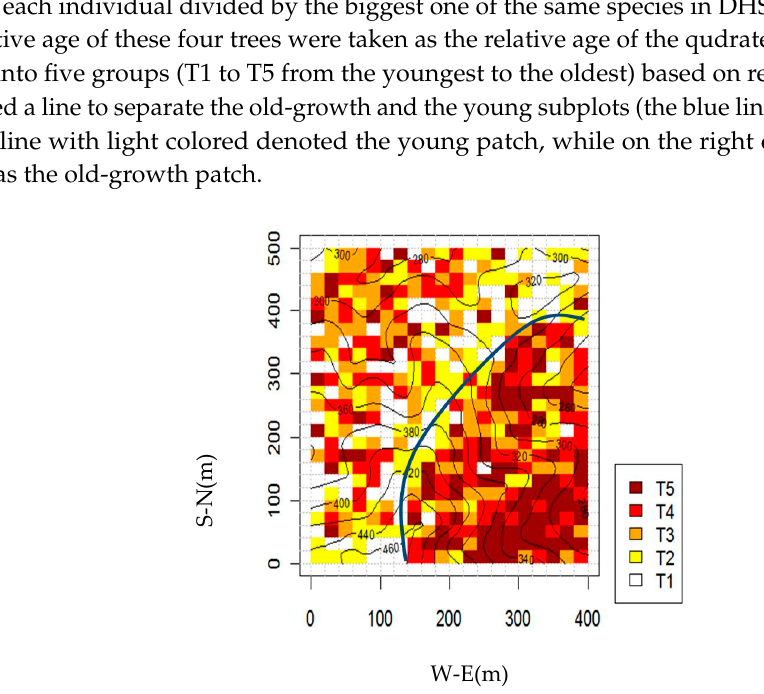
Figure 2. Location of successional forest (left of blue line) and mature forest (right of blue line) within the 20 ha (400 m × 500 m) plot in DHS Plot. From the oldest to the youngest: T5, T4, T3, T2,